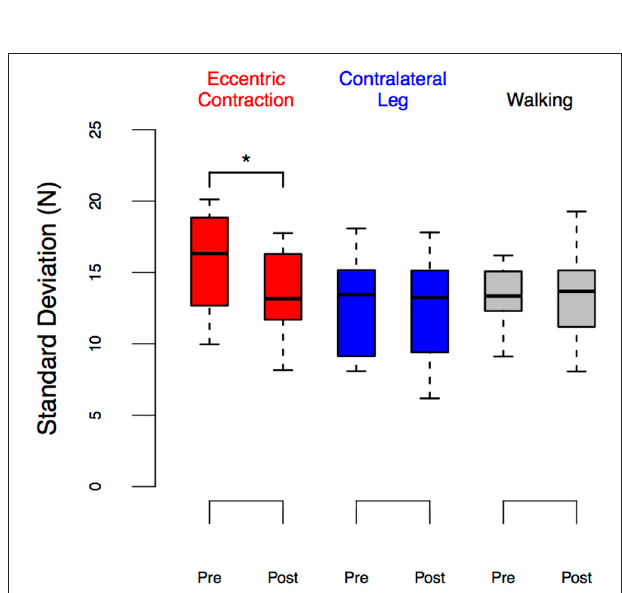
FIGURE 7 | LED SD before and after eccentric contractions or walking in the Exposure group. Group performance is shown as box plots. We observed a significant reduction in LED SD in the leg exposed to eccentric contractions ( p = 0.02) but no changes between pre- and post-exposure in other conditions. *Denotes significant change ( p < 0.05).